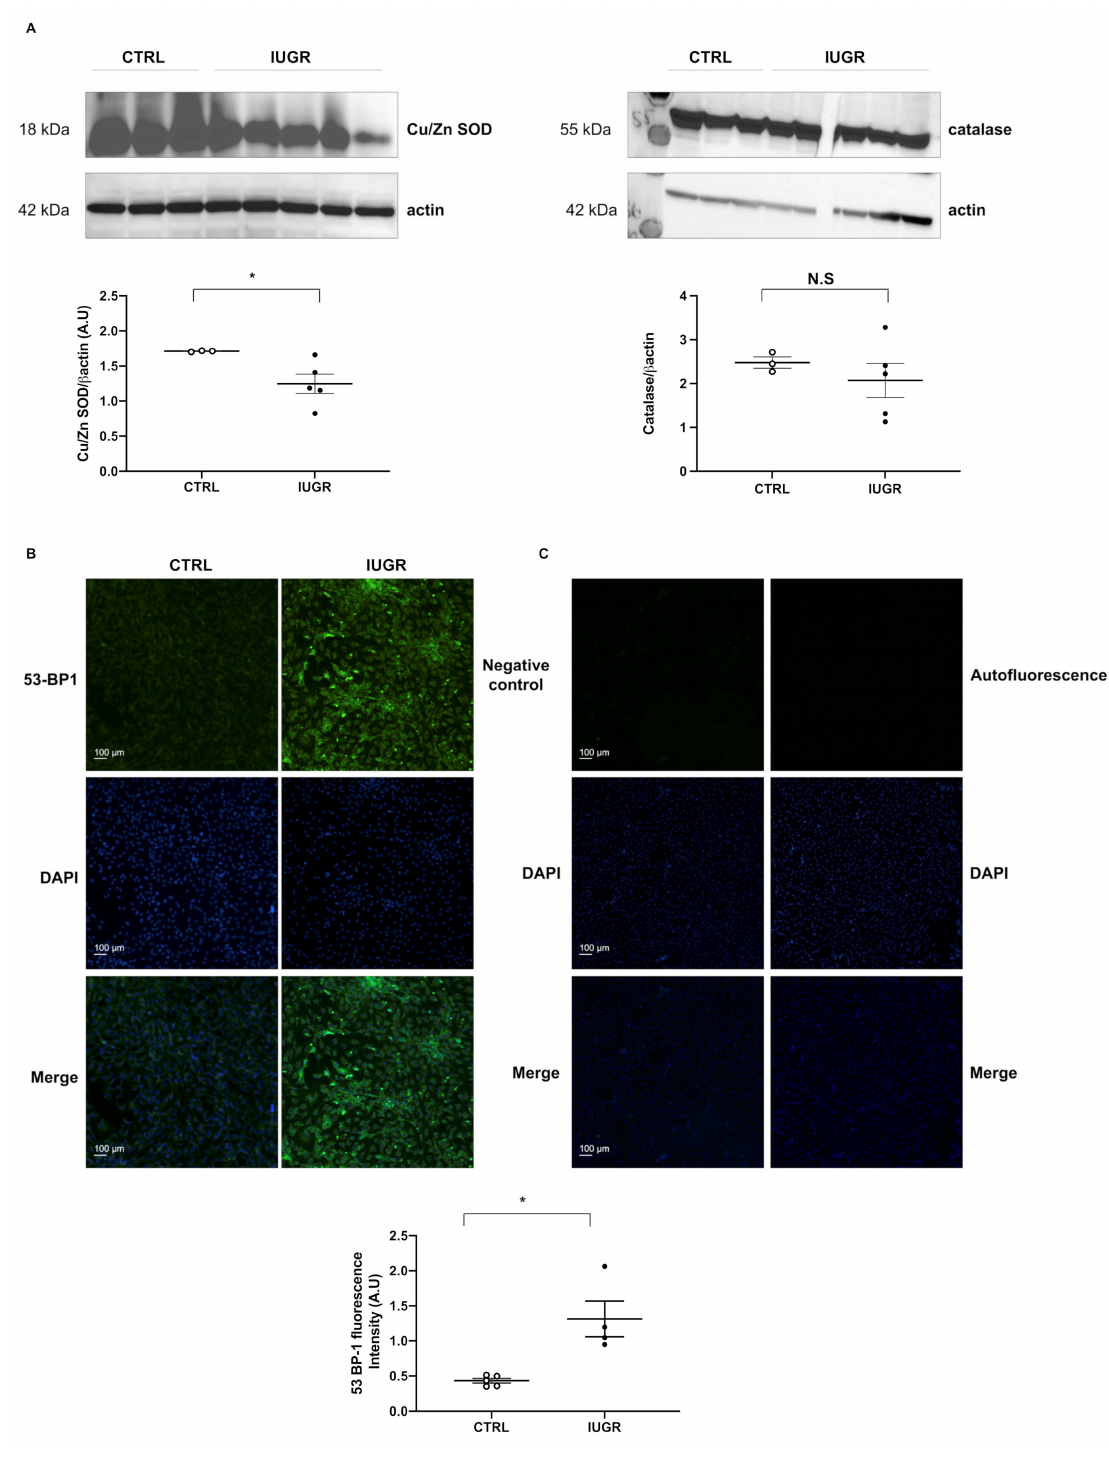
Figure 9. Antioxidant protein expression and DNA damage in ECFCs. The expression of Cu/Zn SOD and cata- lase proteins was measured by western blot in CTRL-ECFCs and IUGR-ECFCs isolated from six-month-old male rats; n = 3–5 animals/group; * p < 0.05 ( A ). DNA double-strand breaks were evaluated by 53BP-1 staining in CTRL-ECFCs and IUGR-ECFCs isolated from six-month-old male rats. Magnification (20 × ) ( B ). Nuclei were counterstained with DAPI, and a negative control (with no primary antibody) and test of autofluorescence were performed ( C ). These pictures are representative images from n = 4–5 animals/group; * p < 0.05; N.S: not significant. Scale bar = 100 µ